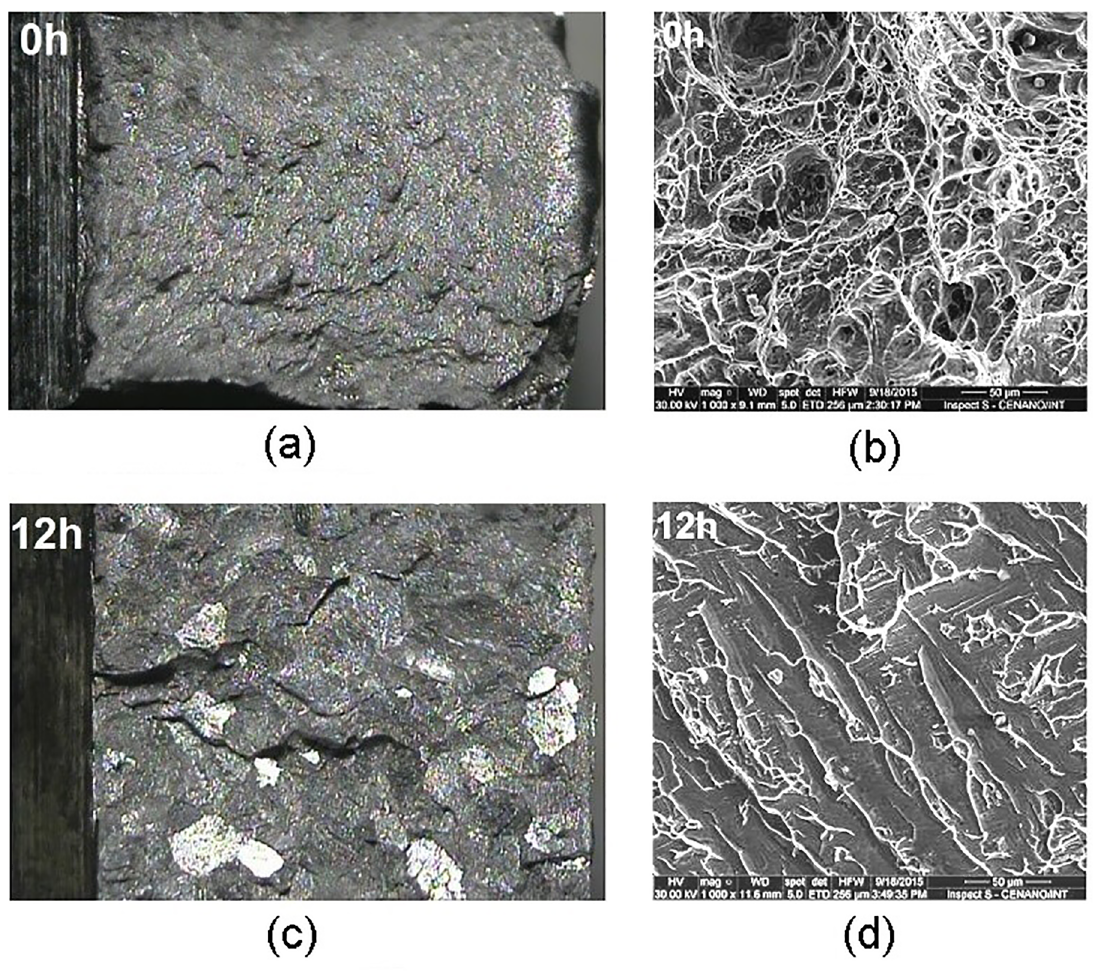
Figure 3. Fracture surfaces of Charpy specimens: (a-b) solution treated; (c-d) 475 o C/12 h.